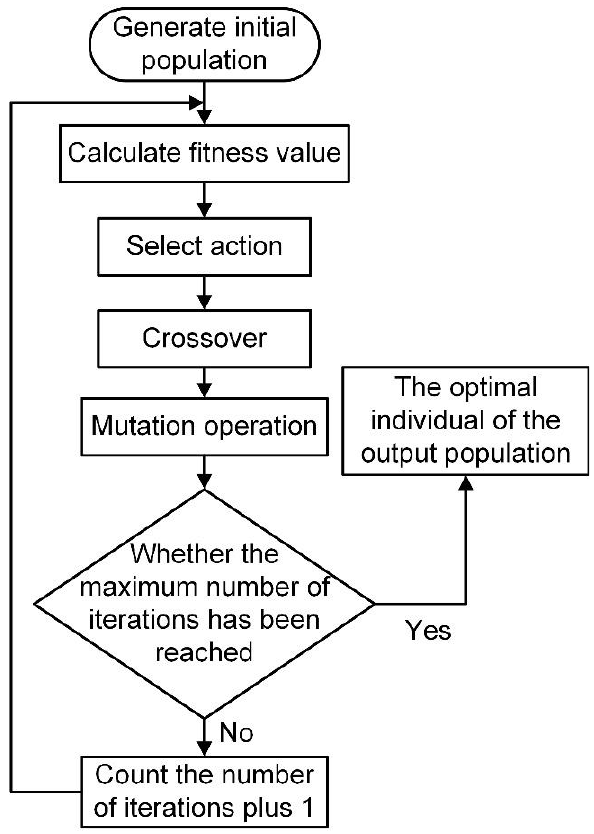
Figure 7. Flowchart of genetic algorithm.